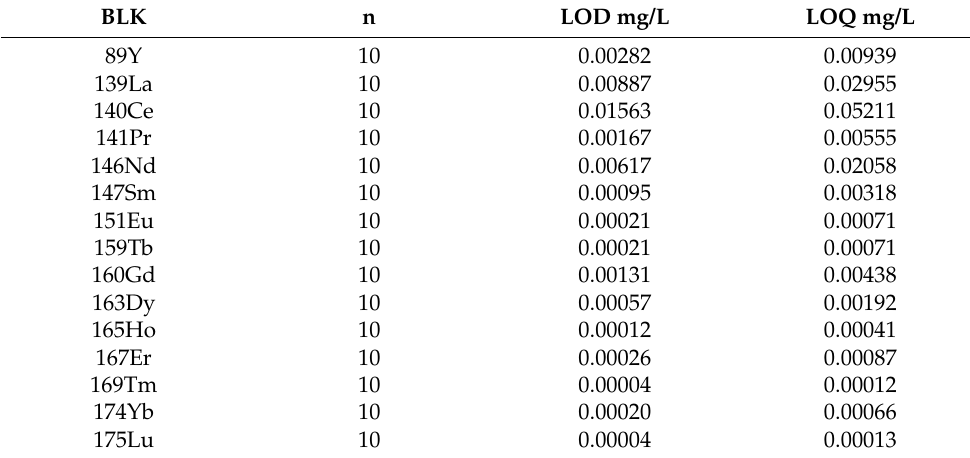
Table 4. Limits of detection (LOD) and quantification (LOQ) as evaluated on the 300Q Perkin Elmer ICP-MS.